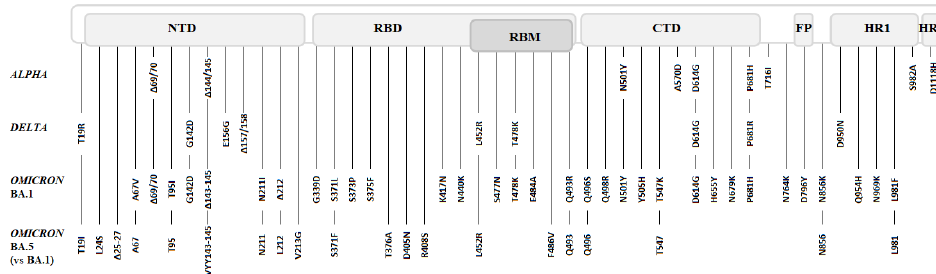
Figure 1. Spike mutations of Alpha , Delta , Omicron BA.1, and Omicron BA.5